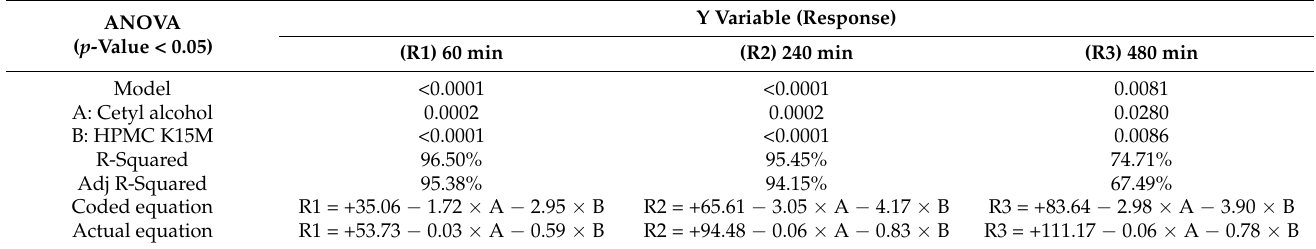
Table 4. Analysis of variance (ANOVA) table of the response surface methodology for three time points. ANOVA ( p -Value <